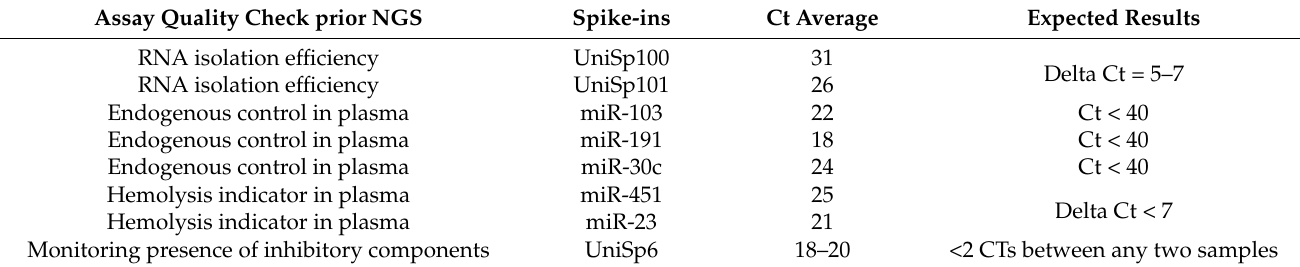
Table 2. Assays included for measuring spike-ins prior to library